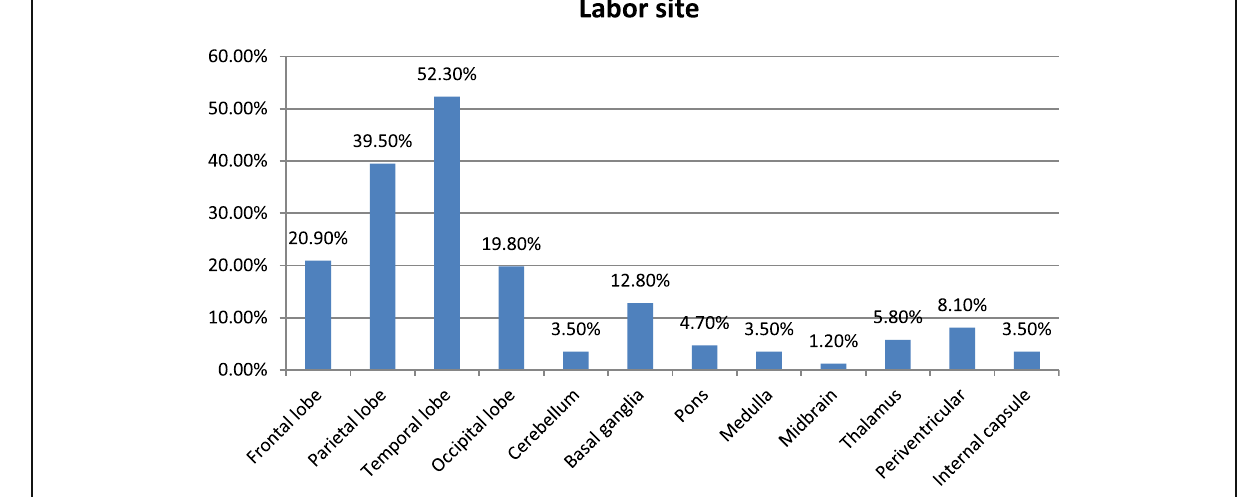
single figure to be statistically analyzed. The results were ranged from 0 to 1 with mean (0.47 ± 0.49)